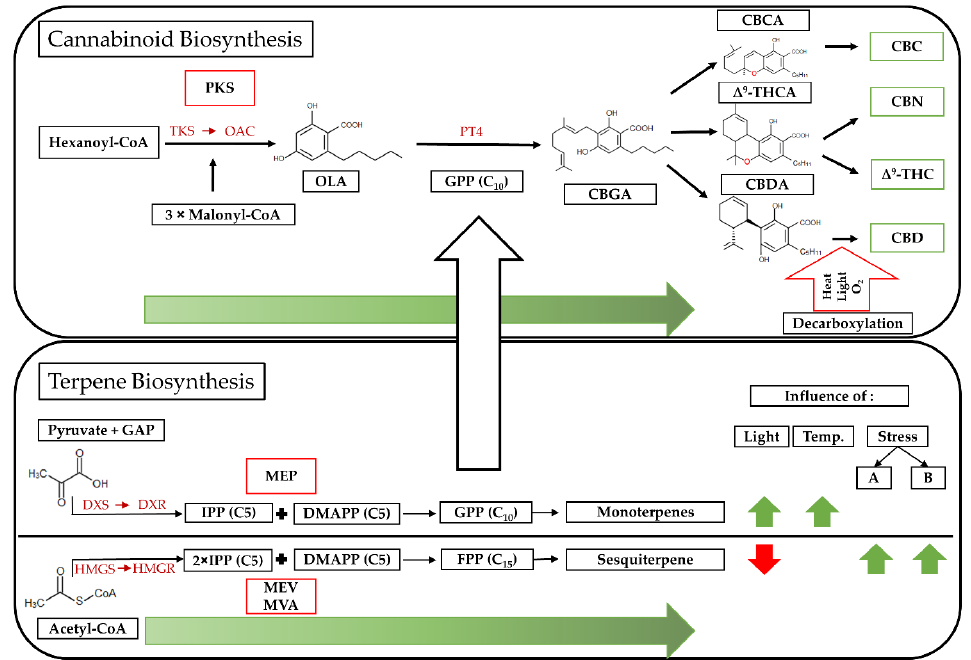
Figure 1. Simplified Cannabis and Terpene Biosynthesis based on [1,3,11,24,25]. Pathways are outlined in red, and important enzymes are highlighted in red. CBCA: Cannabichromenic acid; CBC: Cannabichromene; Δ 9 -THCA: Δ 9 -Tetrahydrocannabinolic acid; Δ 9 -THC: Δ 9 -Tetrahydrocannabinol; CBN: Cannabinol; CBDA: Cannabidiolic acid; CBD: Cannabidiol. For the final conversion into the respective mono- and sesquiterpenes, terpene synthases (TPSs) [25–27] are responsible, which can be classified into different clustering gene groups [3,4] and may be light-mediated [28]. According to [4], TPS-a (caryophyllene and humulene), TPS-g (linalool and nerolidol) and TPS-b ( β -Myrcene, limonene, α -pinene and monoterpenes in general) are responsible for the respective terpene syntheses.